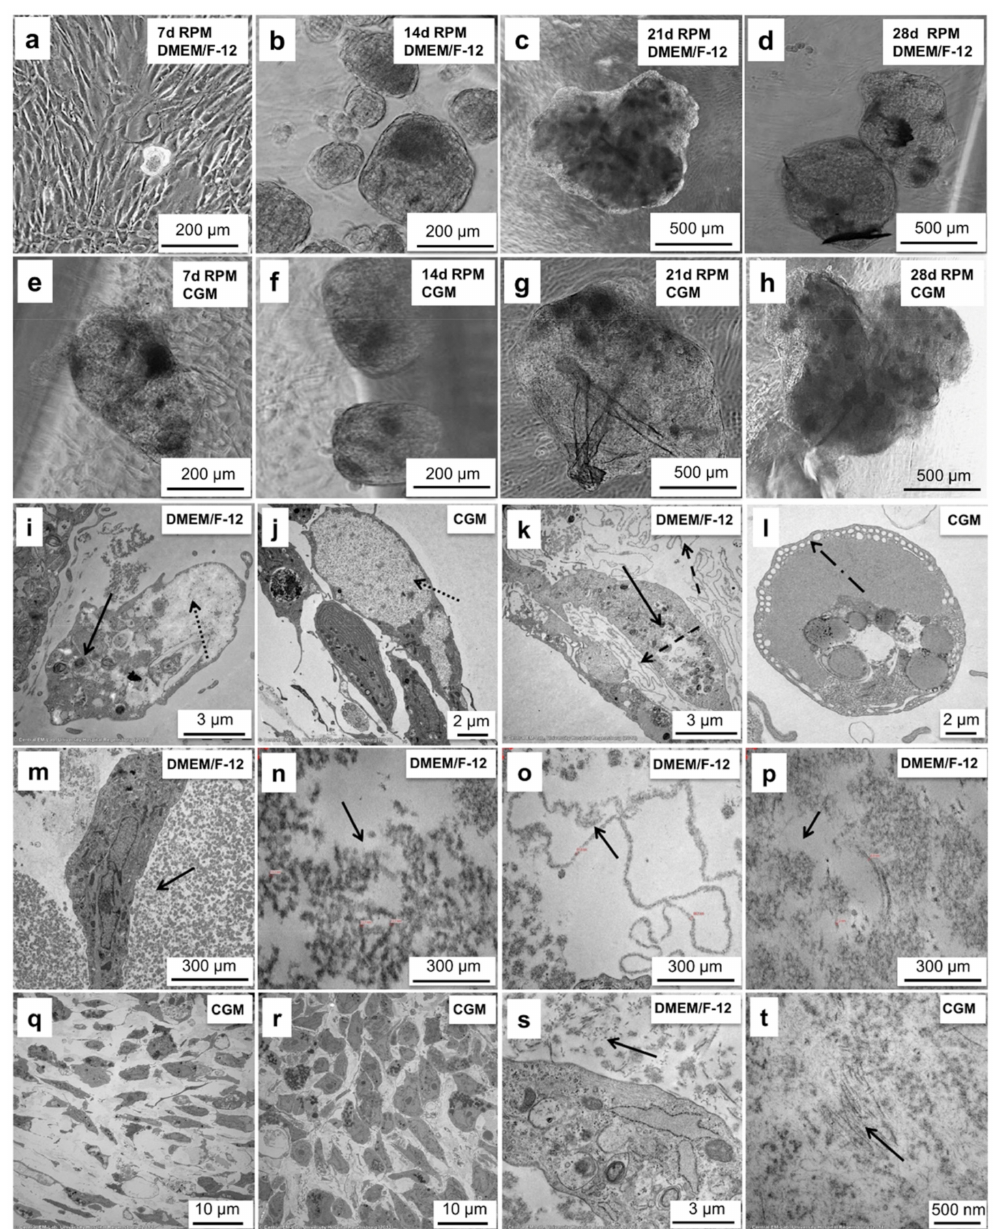
Figure 4. Morphological characterization of spheroids produced from articular chondrocytes on the RPM. ( a ) Spheroids produced during the 7-day-cultivation in DMEM / F-12 medium ( b ) Spheroids produced during the cultivation for 14 days in DMEM / F-12 medium. ( c ) Spheroids produced during the 21-day-cultivation in DMEM / F-12 medium. ( d ) Spheroids produced during the cultivation for 28 days in DMEM / F-12 medium. ( e ) Spheroids produced during the cultivation for 7 days in CGM medium. ( f ) Spheroids produced during the cultivation for 14 days in CGM medium. ( g ) Spheroids produced during the 21-day-cultivation in CGM medium. ( h ) Spheroids produced during the cultivation for 28 days in CGM medium. ( i ) Accumulation of glycogen (dotted arrow) and lysosomes (solid